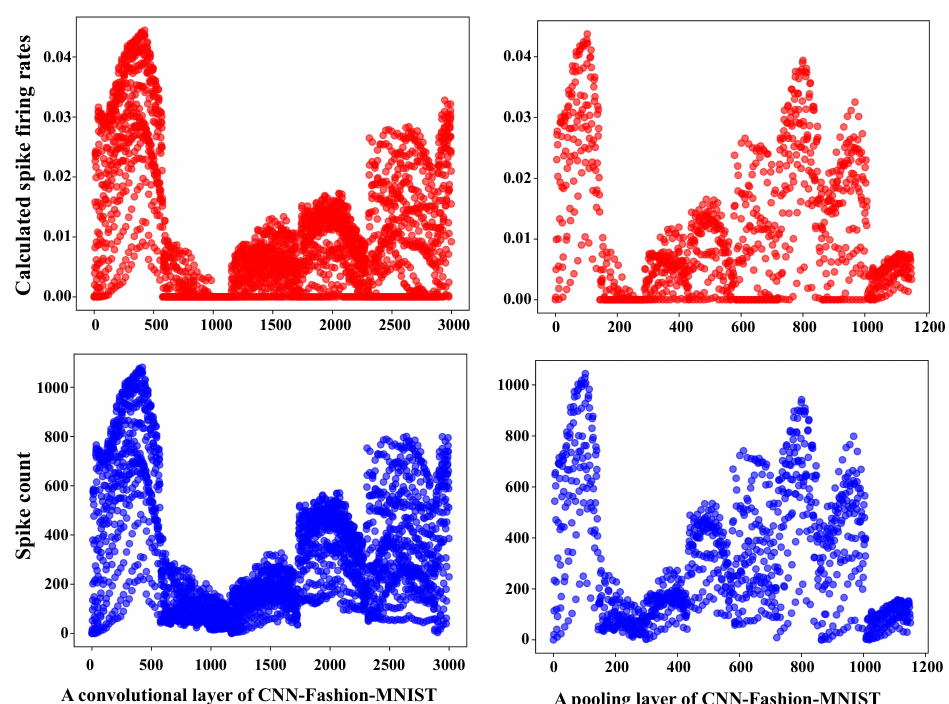
Figure 10. The calculated spike firing rates and actual spike count in different layers of CNN-Fashion- MNIST. The horizontal axis is the number of neurons.